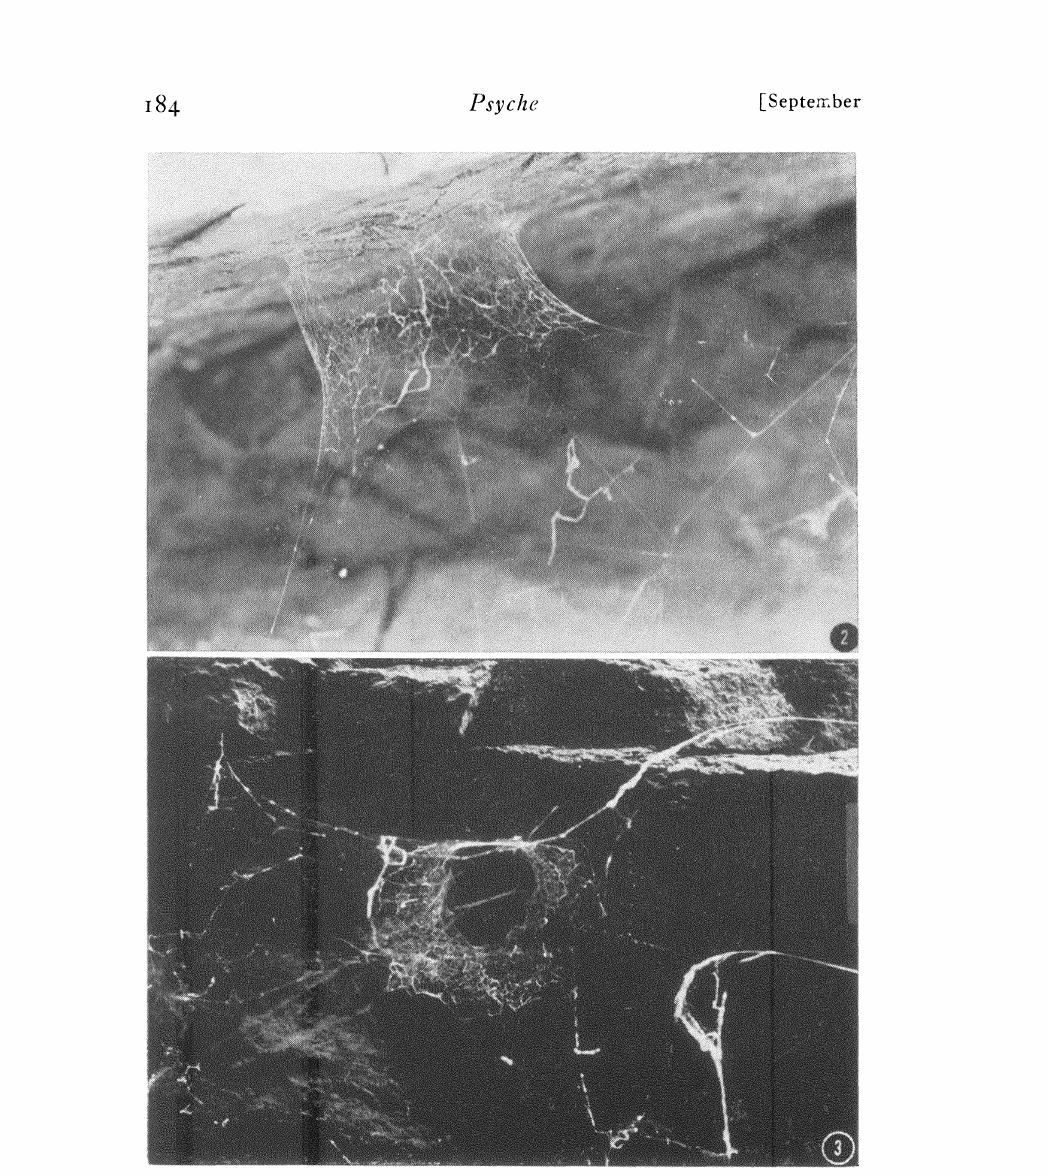
Figure 2. Web of H. thorelli, lateral view. Note position of spider against substrate. Photo by L. Tucker. Figure 3. Web of H. thorelli seen from below. Note tangle and flaring of lampshade. The spider is at the center of the web